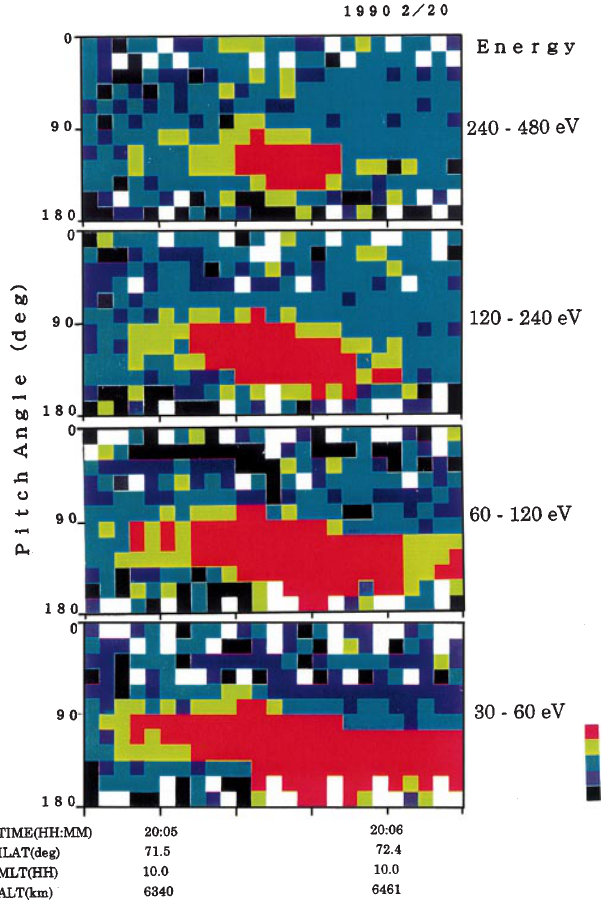
Fig. 1. An example of ion conics observed during a poleward passage of dayside auroral region. The local time was about 10:00 and the altitude was about 6000 km. The red area represents the highest count rates. The white area shows no available data in the bin. One step of color code corresponds to half a decade. Note that the conics have a conic angle near 90 (cid:14) and low energy near the low-latitude boundary, and a conic angle near 60 (cid:14) and maximum energy inside the conic